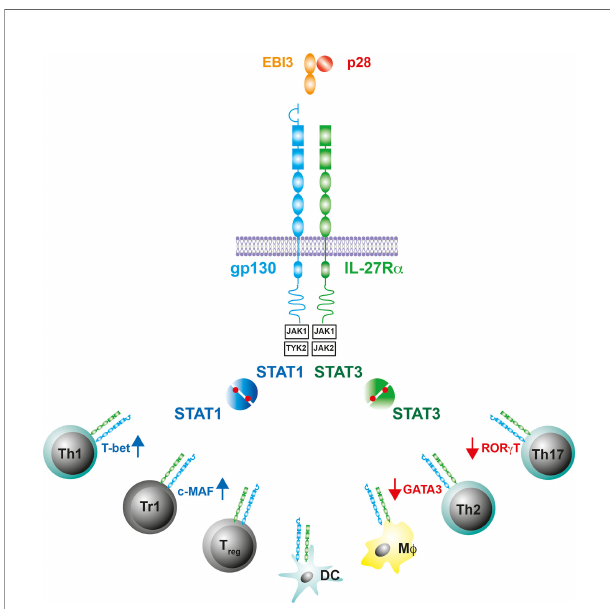
FIGURE 1 | IL-27 and the IL-27R. The gp130 cytokine IL-27 is a heterodimeric cytokine comprising of a secreted receptor a -subunit and four-helix bundle protein (IL-27p28/EBI-3). The receptor complex for IL-27 contains gp130 and the IL-27R subunit- a , which is structurally similar to gp130. The intracellular domains of the receptor complex associate with the Janus kinases JAK1, JAK2 and Tyrosine kinase (TYK)2. IL-27-induced conformational changes of the receptor complex activate JAK1/TYK2 or JAK1/JAK2 and initiate a phosphorylation cascade that leads to the activation of signal transducer and activator of transcription (STAT)1 or STAT3, respectively. The IL-27R is predominantly expressed onT cells, M f and DC where the Il-27R-mediated activation of STAT1/ 3 differentiallyaffects the production of cell-type speci fi c transcription